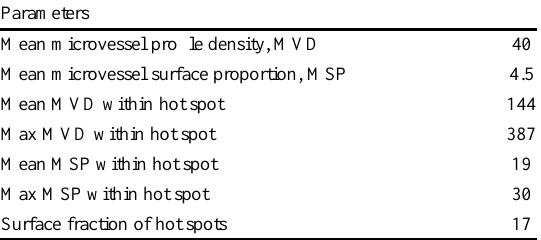
Measures obtained by the automatic procedure (case presented in Fig. 3). All microvessel profile density (MVD) were expressed as number per mm 2 of tumour tissue. All surface proportions